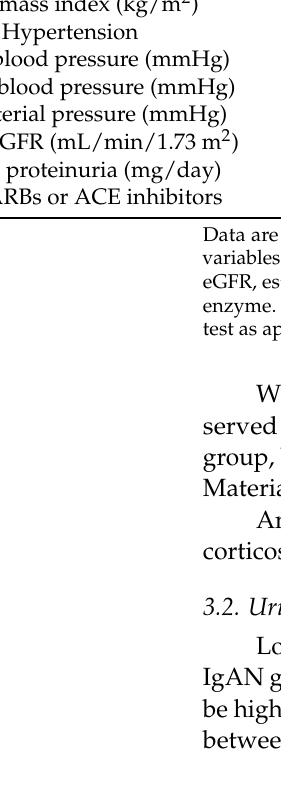
Table 1. Baseline characteristics of the MHC, MCD, and IgAN groups in the prospective study.